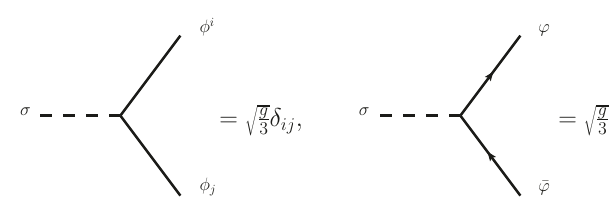
Figure 8 . The interaction vertices of the Lagrangian given by